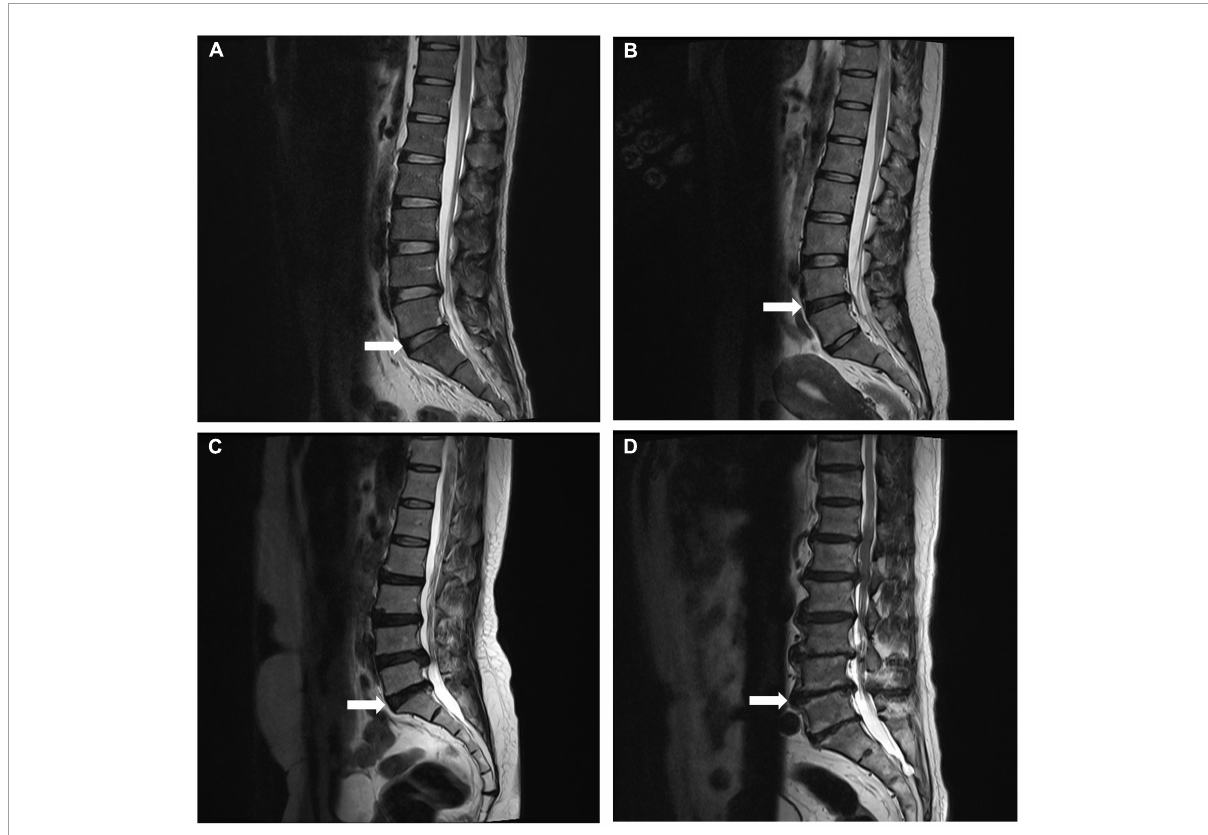
FIGURE1 Representative MRI images used for Pfirrmann grading system of lumbar disc degeneration. Midsagittal T2-weighted views showing grade 2 (A) , grade 3 (B) , grade 4 (C) , and grade 5 (D) degeneration of the lumbar disc.